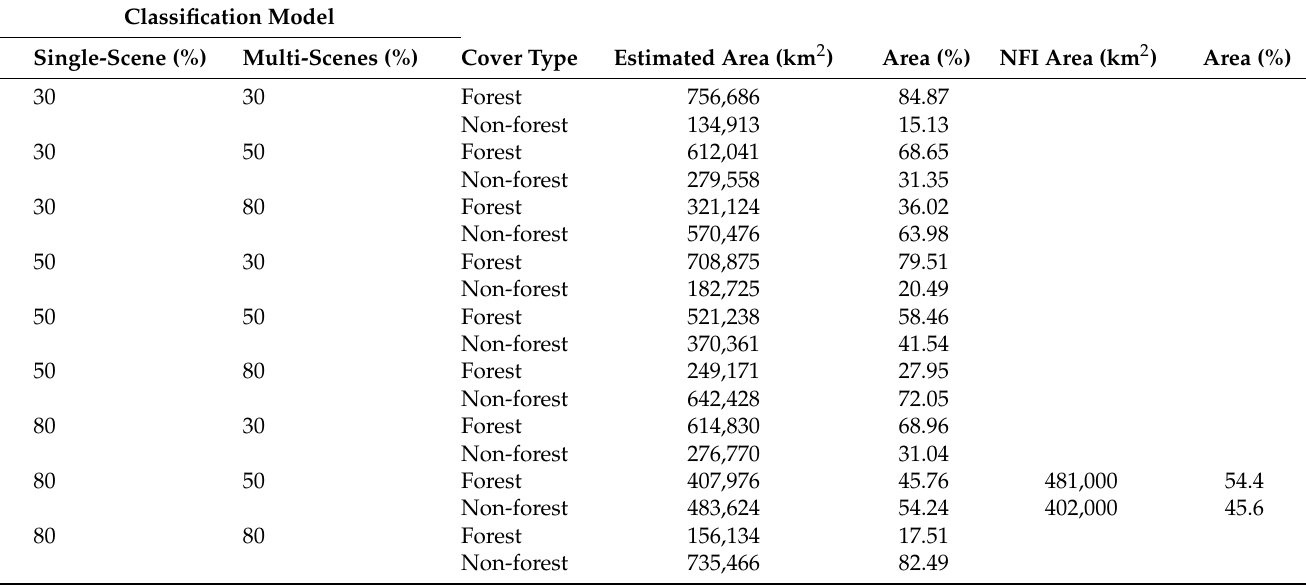
Table 5. Estimated forest area from the classification results for the nine models; compared with the National Forest Inventory (NFI)—NAFORMA [20]. Classification